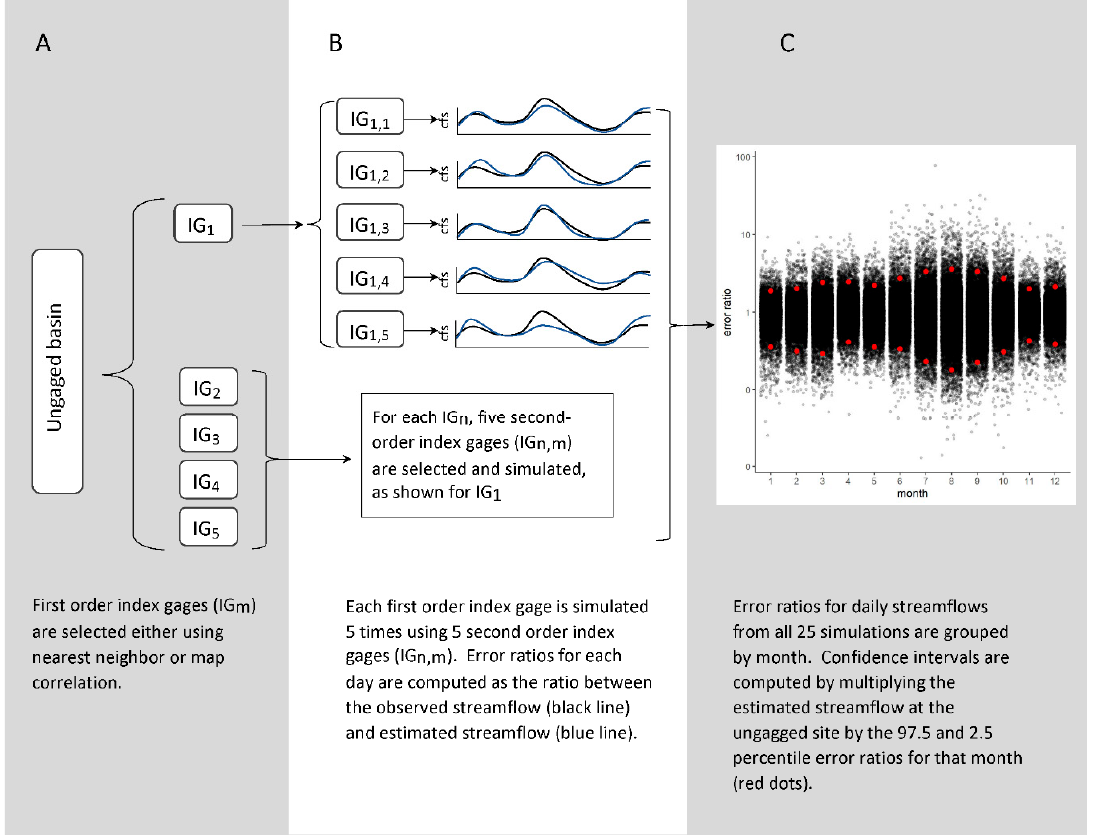
Figure 2. Schematic diagram of the process used to compute uncertainty intervals for daily streamflows. First order index gages are selected ( A ) and simulated as if they were ungaged using 5 second -order index gages ( B ). Daily error ratios are grouped by month ( C ). Confidence intervals are computed by multiplying the daily estimated streamflow at the ungaged site by the 97.5 and 2.5 percentile error ratios of the appropriate month.